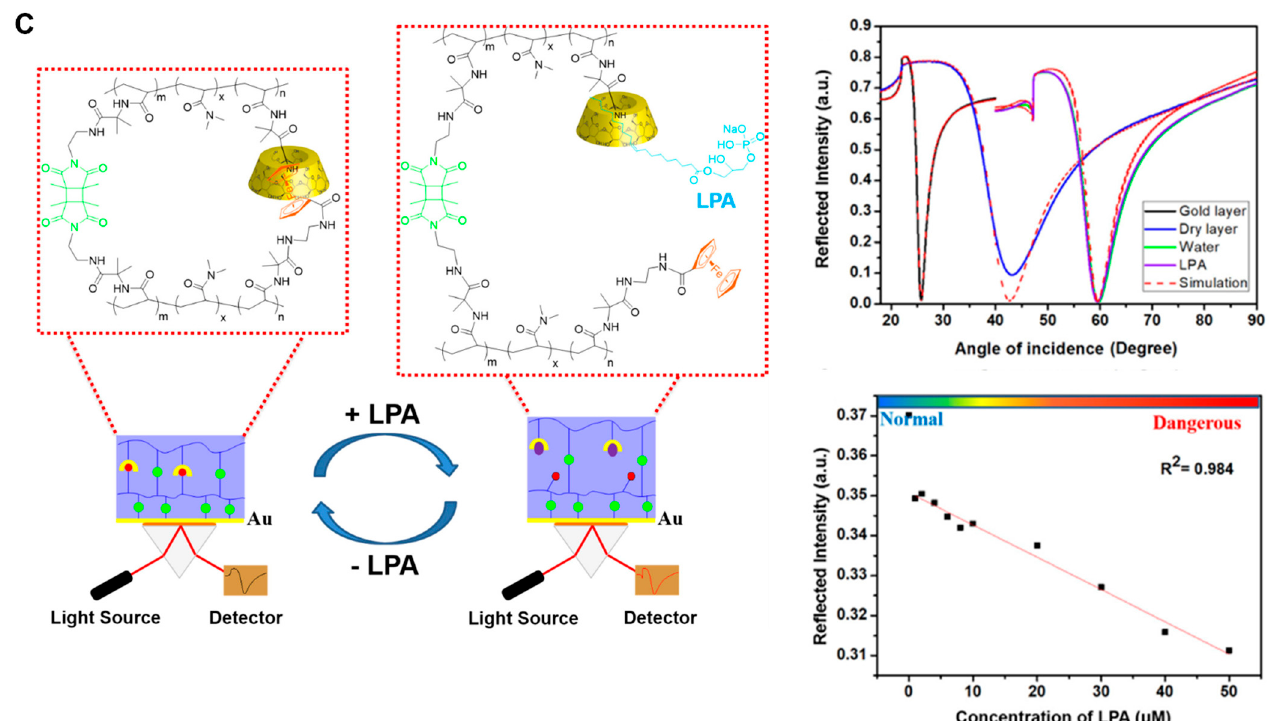
Figure 7. ( A ) (a) Image of the sensor (A—photopolymer; B—free gold surface; C—hydrophobic paint); (b) SPR photograph of the sensor acquired via a CCD camera. (c) The functional component of the device is depicted schematically [130]. (d) Change in the SPR angles with different concentration of antibodies. ( B ) A schematic depiction of biophysical interaction between exosome and SAM-AuNIs. Exosome detection sensitivity using LSPR. The study employed the LSPR sensitivity of three distinct exosomal concentrations (1 µg/mL, 10 µg/mL, and 100 µg/mL); the highest phase responsiveness was recorded at 100 µg/mL [140]. ( C ) The SPR-OWS sensor, which incorporates a dually crosslinked supramolecular hydrogel to identify LPA, is shown schematically. [142].